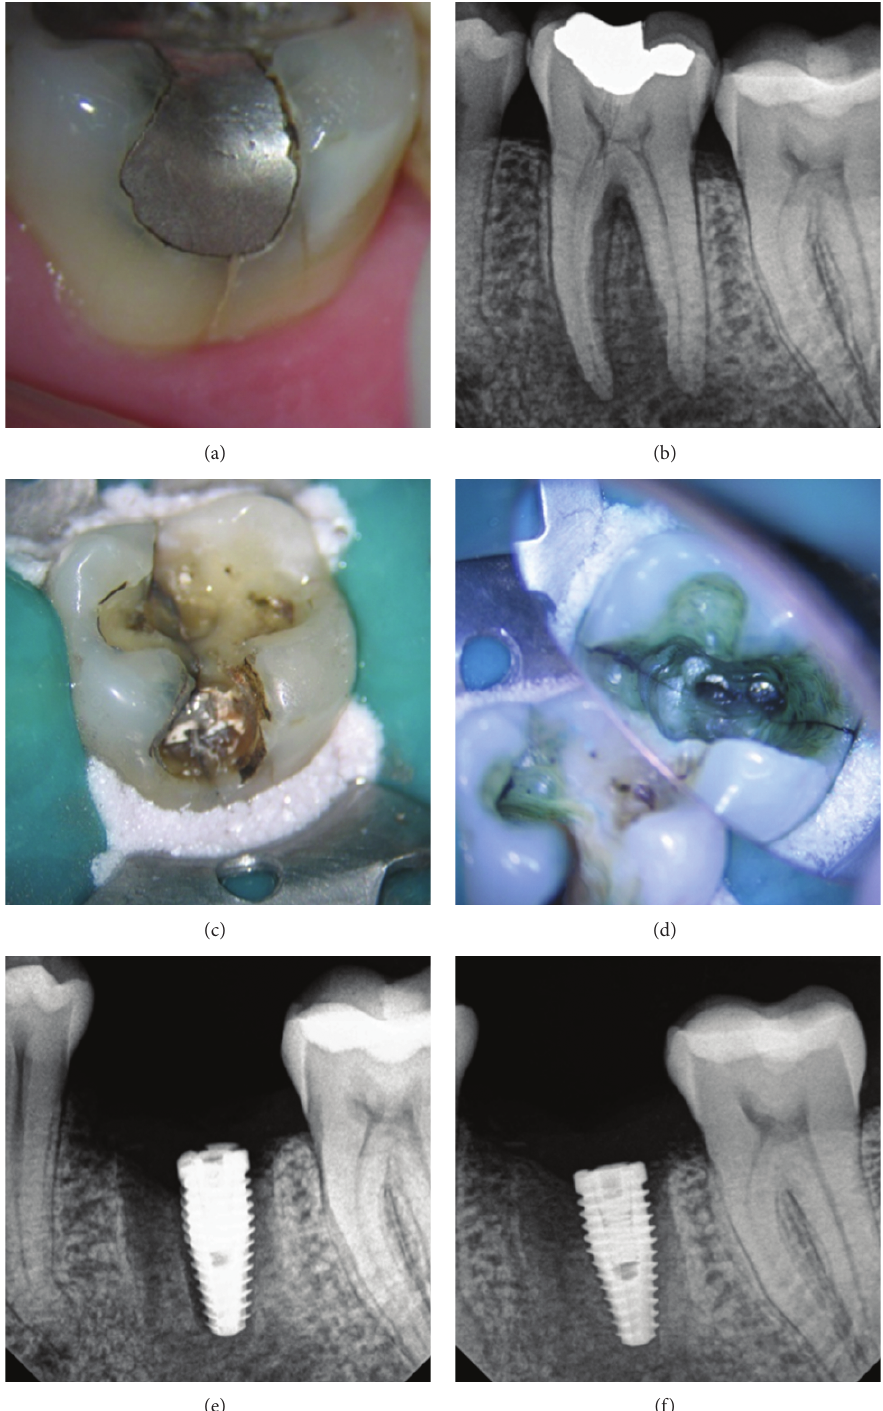
Figure 2: Initial clinical aspect. Note the fracture in vestibular region below the end of restoration (a). Radiograph aspect with diffuse radiolucent image (b). Clinical aspect after removal of restoration (c). Application of dye (SableSeek, Ultradent) confirming the presence of RVF (d). Radiographic image after installation of the immediate implant (Neodent, 10.0 × 4.3 ) (e). Radiograph aspect 4 months after immediate implant installation